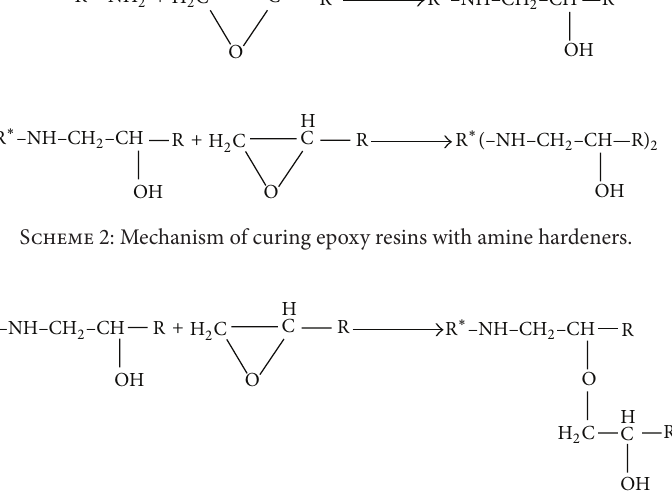
Scheme 3: Illustrating the mechanism of etherification